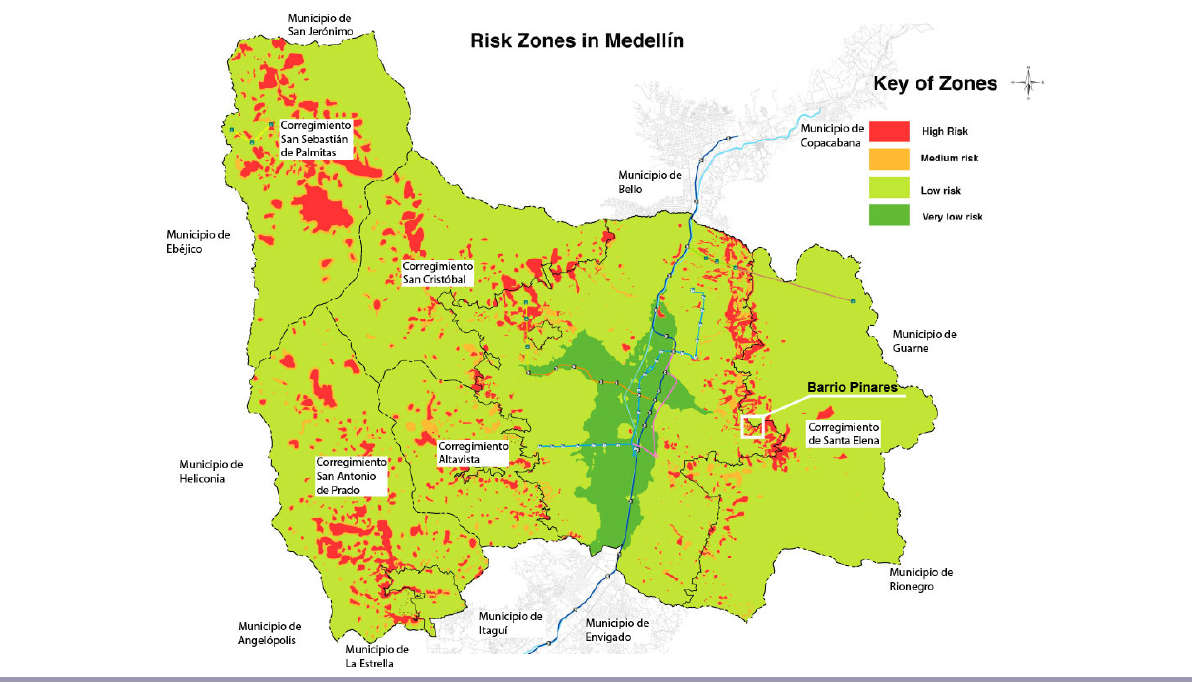
Fig. 1 . Map of risk zones in Medellín. Source: adapted by the authors from Empresa de Desarrollo Urbano (Urban Development Agency)